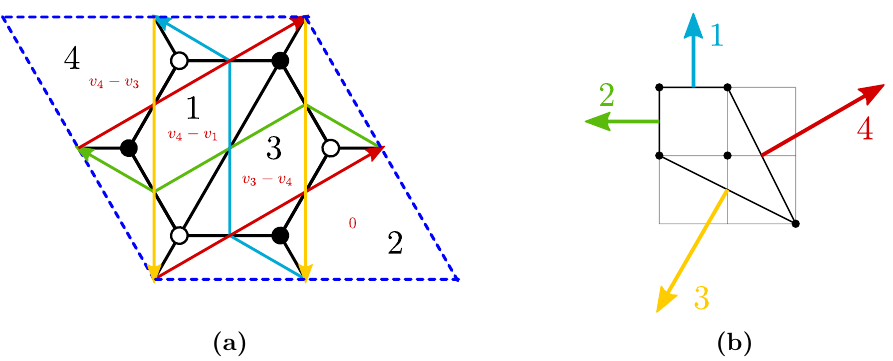
Figure 3. (a) Dimer diagram for dP 1 . We show the ZZPs and the rank assignments coming from them. (b) The toric/web